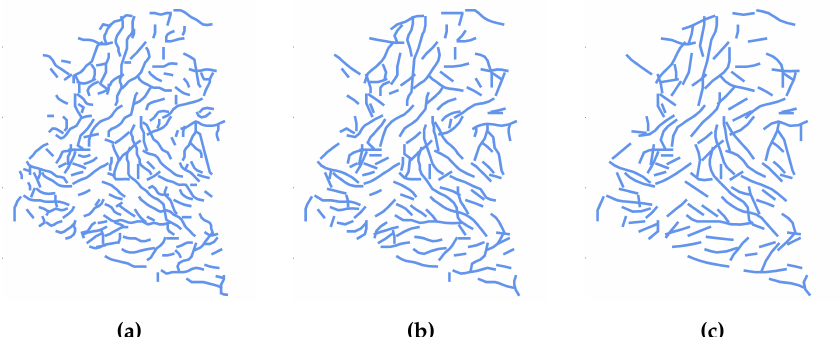
Figure 6. Detected objects, different minimum length l min and number of detected objects n . ( a ) l min = 4 px, n = 208; ( b ) l min = 6 px, n = 160; ( c ) l min = 8 px, n =